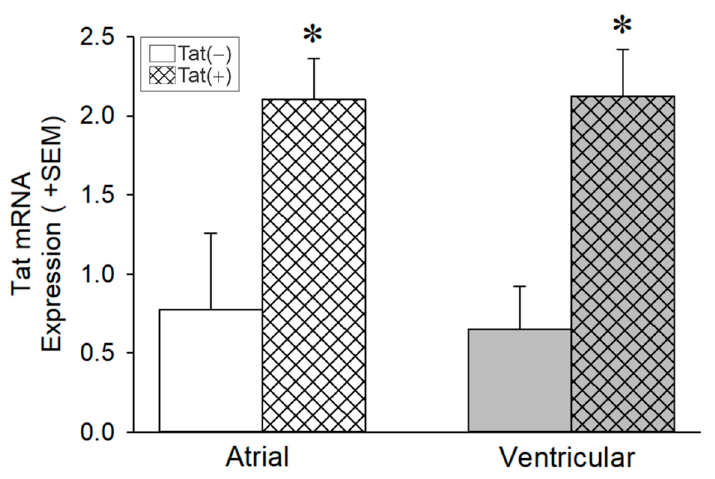
Figure 2. tat mRNA Expression in the Heart. tat mRNA expression was detected in the whole heart of Tat(+) mice (hatched bars) compared to their control Tat( − ) mice (open bars; n = 2–3 per group). * indicates a main effect of genotype wherein Tat(+) mice differ from Tat( − ) controls; p < 0.05; two-way ANOVA.